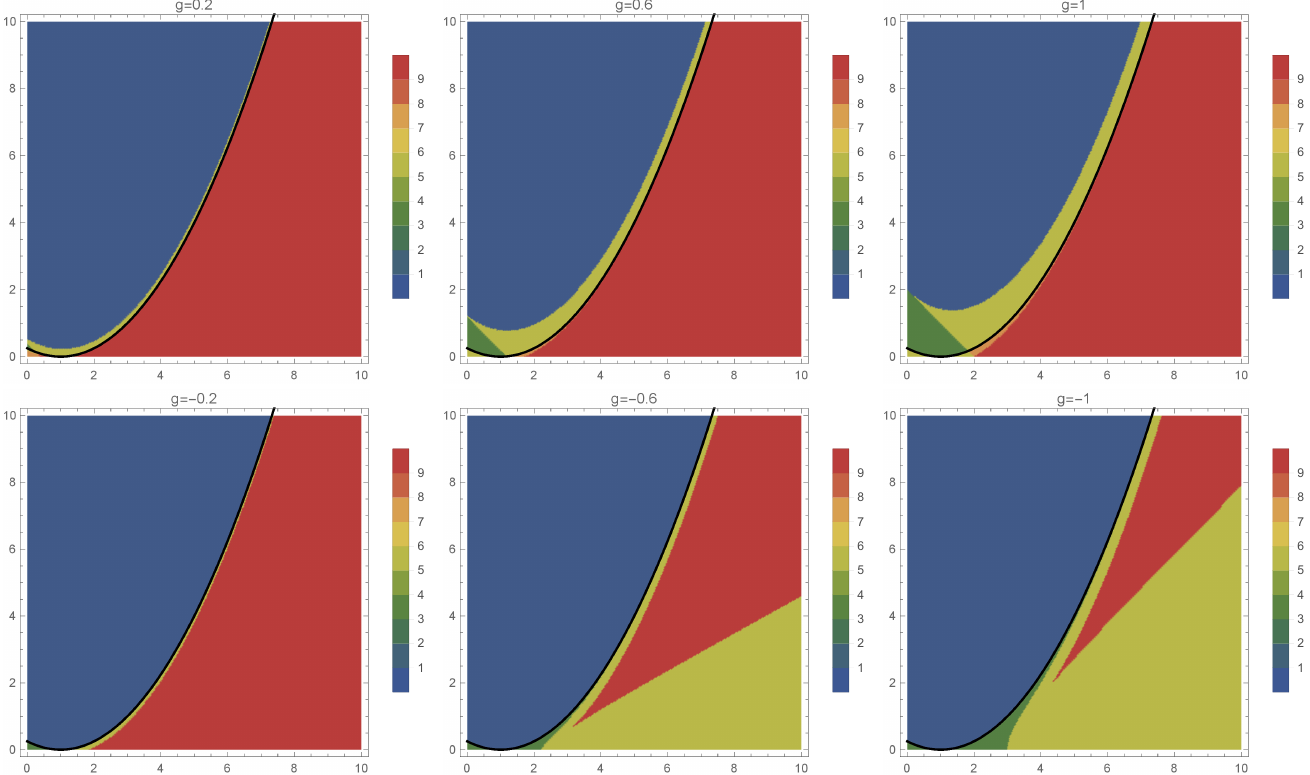
Figure 1. Number of equilibrium states in the parametric plane ( a , α ) for different values of the parameter g ∈ {± 0.2, ± 0.6, ± 1 }